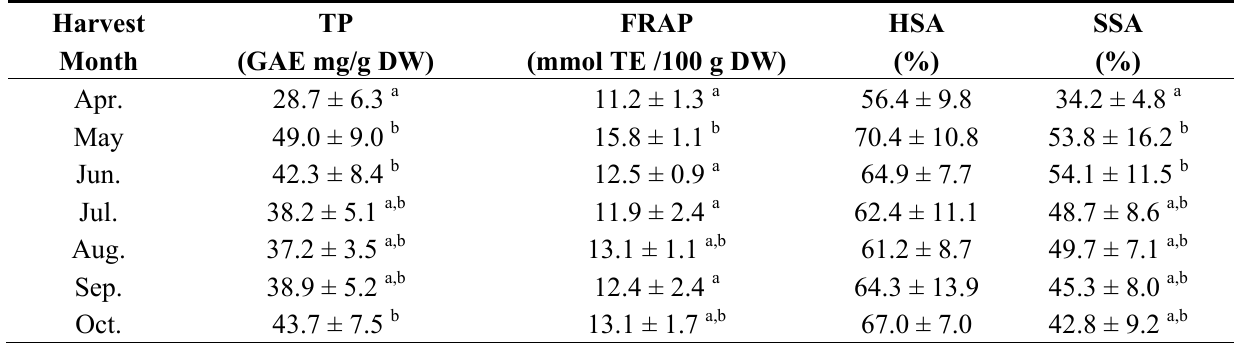
Table 5 . Effect of harvest month on TP and antioxidant activity of mulberry